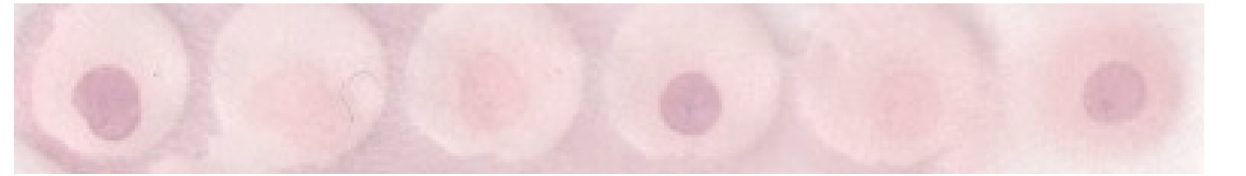
Figure 1: SeA production by S. aureus isolated from Mexican artisanal cheeses. From left to right: positive control, negative control, and isolates from cheese. Table 3: MRSA and S. aureus enterotoxigenic in artisanal Mexican cheese. Cheese